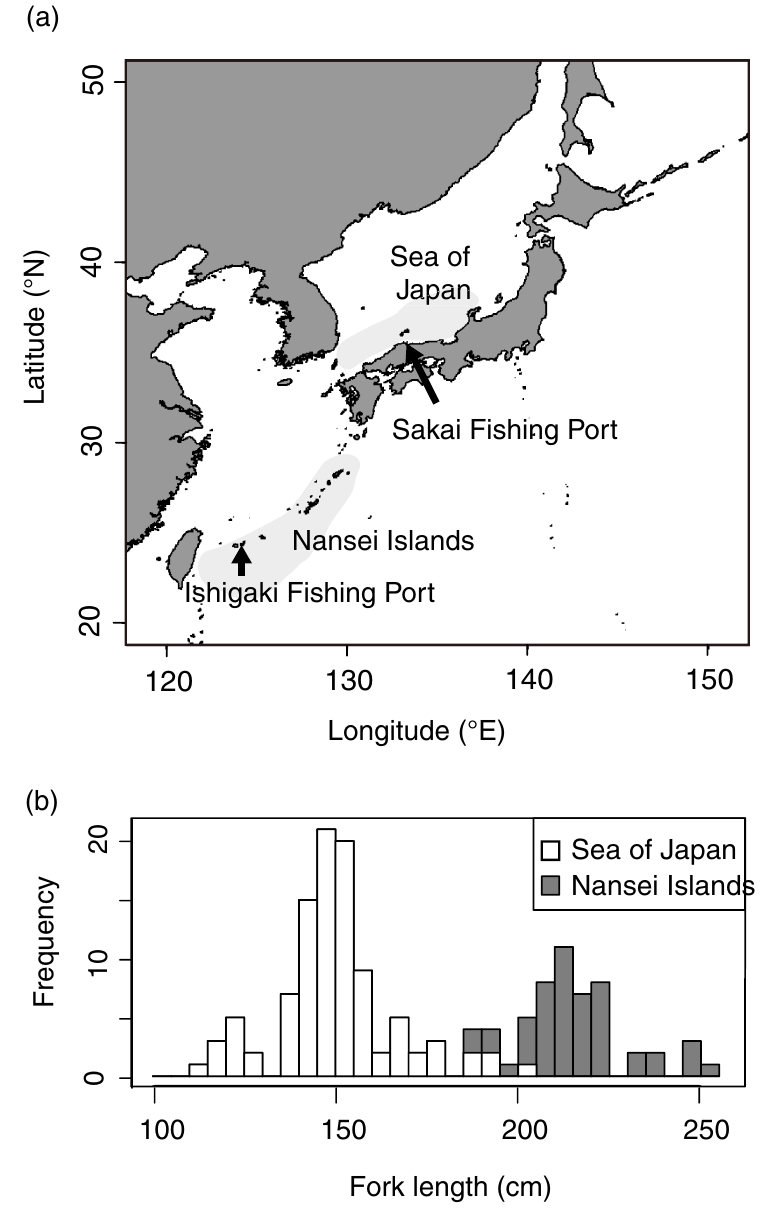
Fig 1. Location of Pacific bluefin tuna major spawning grounds, fishing ports (a), and length composition (b). The digital map data was obtained from Natural Earth. from the Nansei Islands were sampled between late April and late June. At Sakai Fishing Port, 100 females from the Sea of Japan were sampled between mid-June and early July. Fishes from each spawning ground were sampled for ovary, muscle, and liver tissues in 2015–2017, 2016– 2017, and 2017, respectively (Table 1). Fork length (FL, cm), gilled and gutted body weight (BW, kg), and gonad weight (GW, g) were recorded for each female. A gonad-somatic index (GSI) was calculated for each following GSI = GW × 100/BW. White muscle was sampled from near the caudal fin. Ovary, liver and muscle tissues for fatty acid and lipid analyses were frozen. Other ovary sections were fixed in 10% buffered neutral formalin for histological observation.